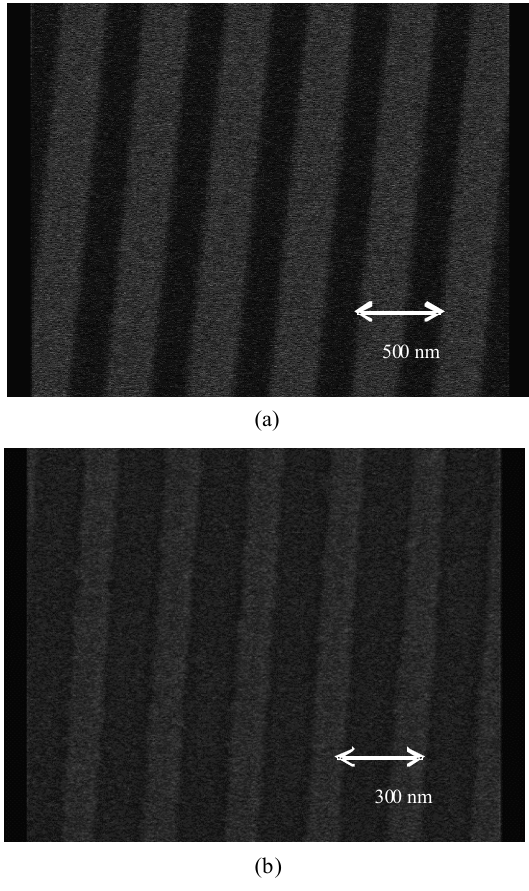
Fig. 5 SEM images of the fabricated samples: (a) period of 500 nm and (b) period of 300 nm.